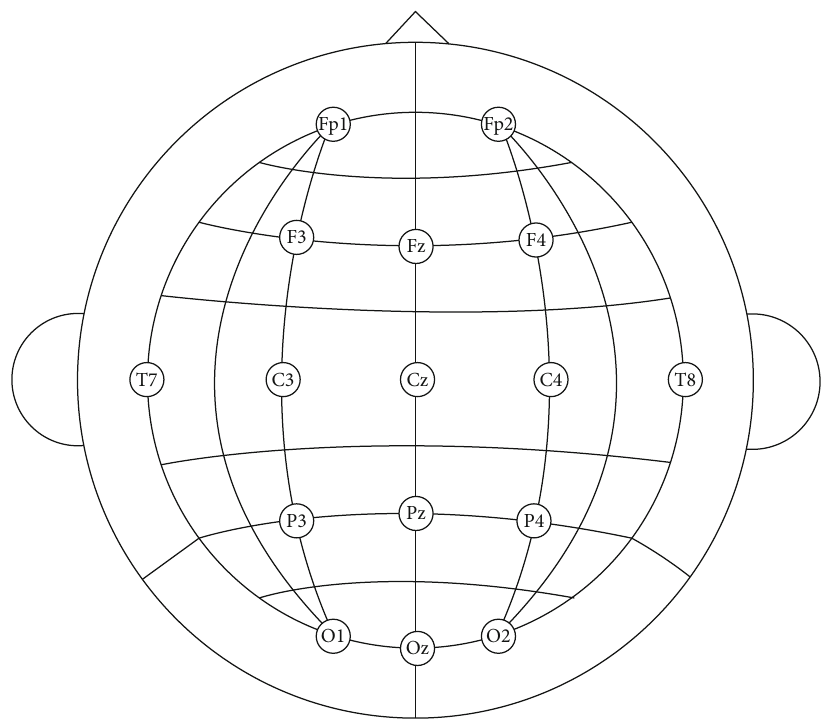
Figure 2: Cap 16-electrodes